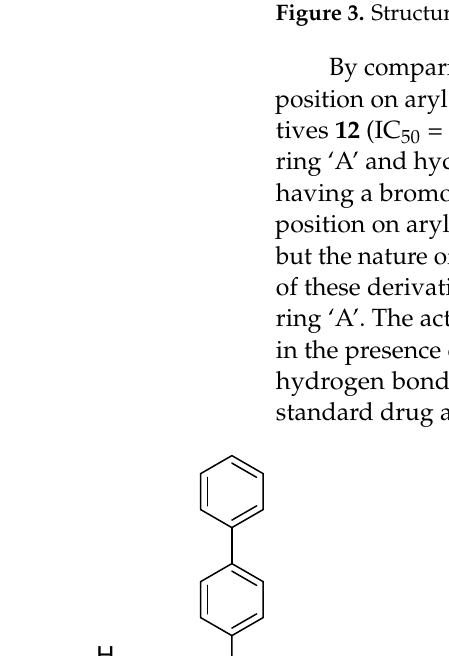
Figure 3. Structure–activity relationship of derivatives 7 , 8 and 9 .